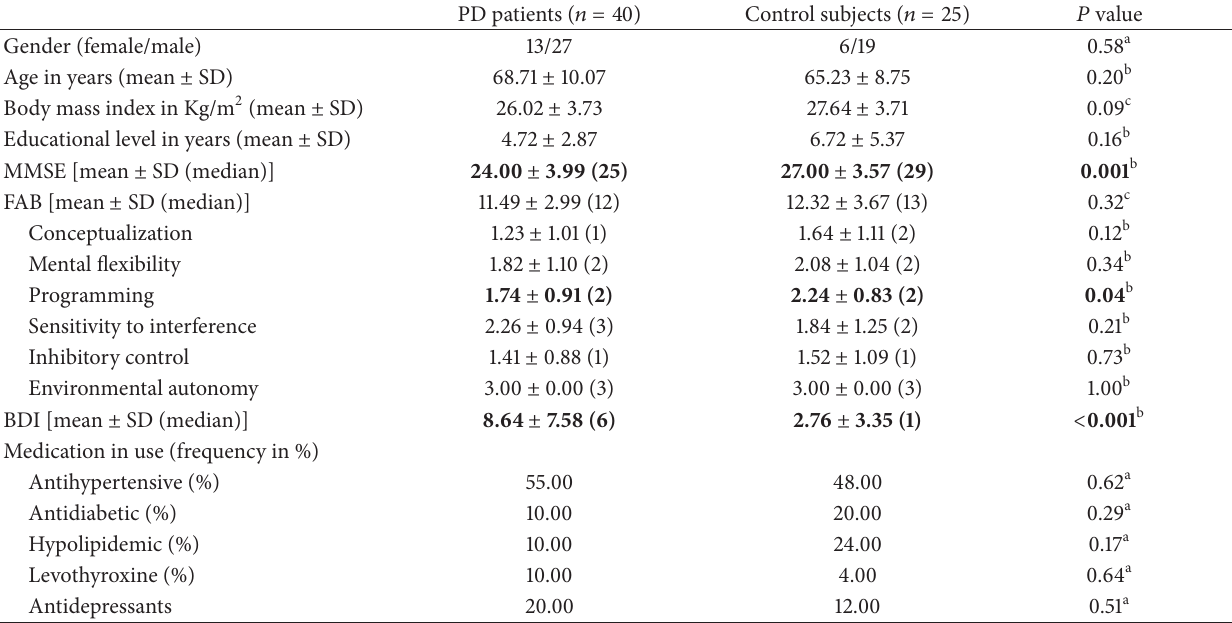
Table 1: Demographic and nonmotor features of Parkinson’s disease (PD) patients and control